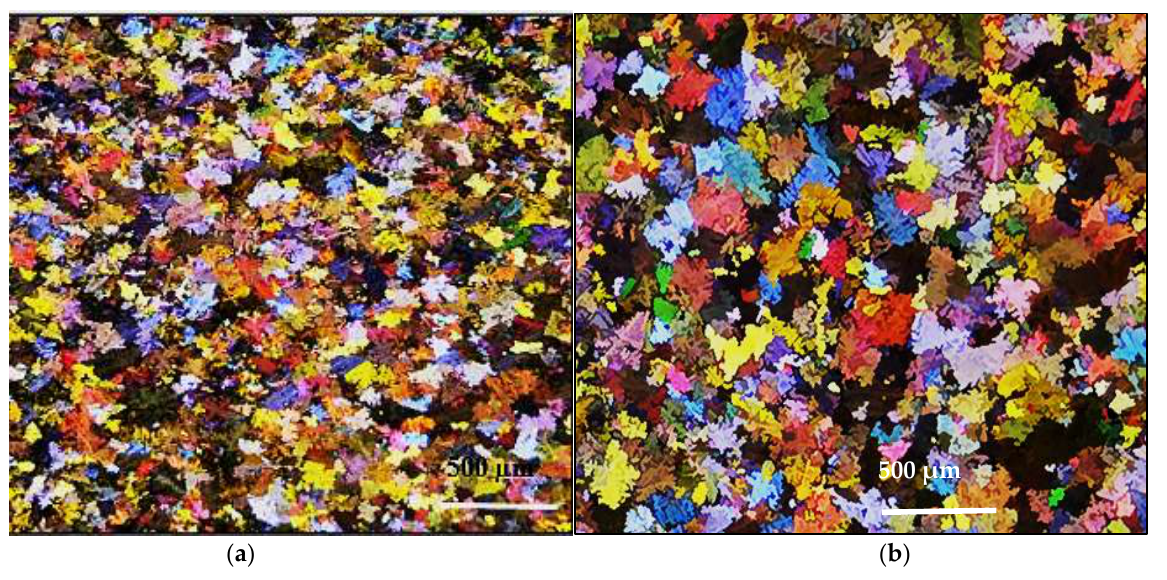
Figure 1. Macrostructure of grain size distribution in: ( a ) alloy A and ( b ) alloy D in the as-cast condition.